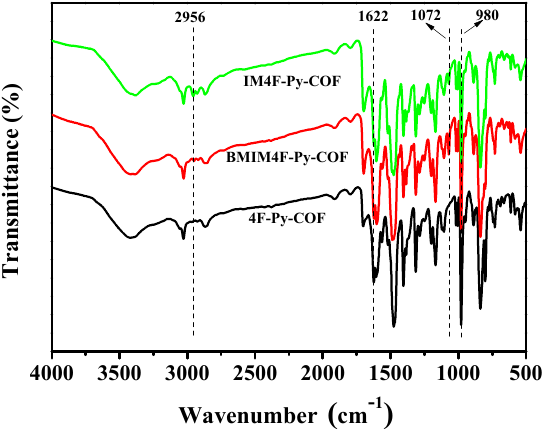
Figure 3. FI-IR spectra of IM4F-Py-COF, BMIM4F-Py-COF, and 4F-Py-COF.